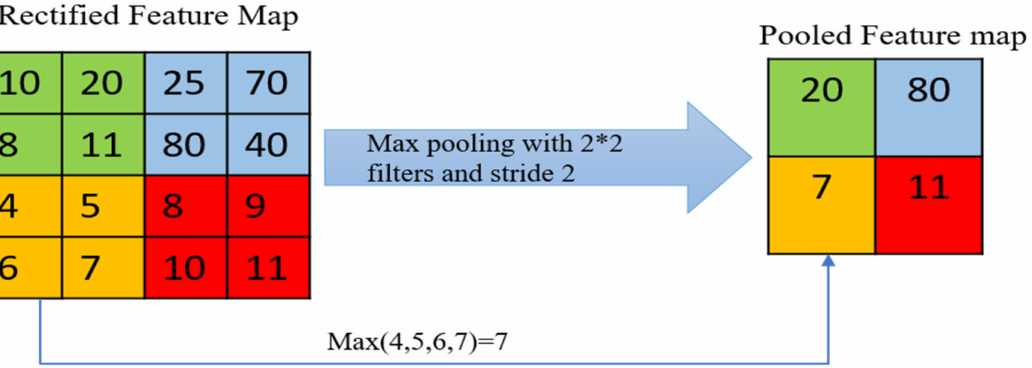
Figure 2. Max pooling operation